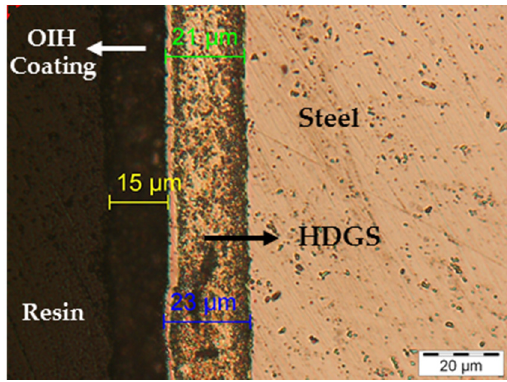
Figure 6. Stereoscopic observation of the corrosion products formed on HDGS during immersion in highly alkaline solution. ( a ) Generic view and ( b ) detail of the morphology of the calcium hydroxyzincate crystals formed.